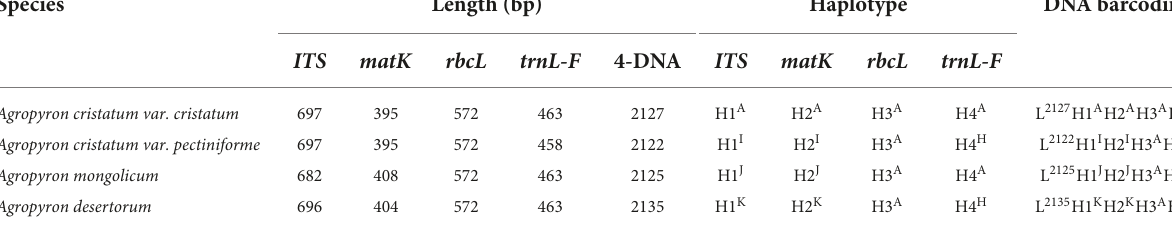
TABLE 4 Database of DNA barcoding for four samples of Agropyron species. Species